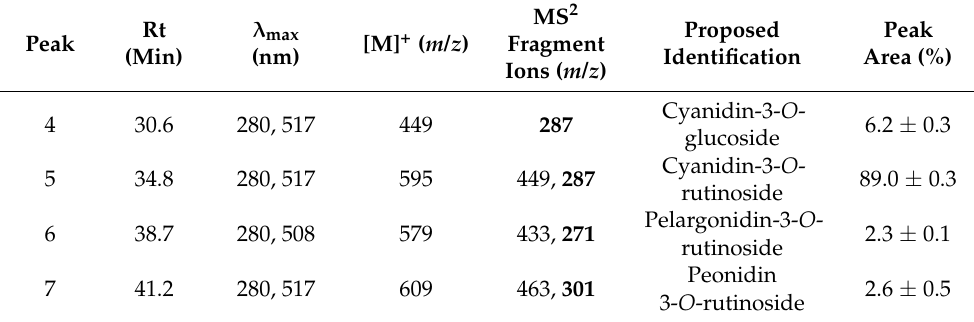
Figure 1. Chromatograms of açaí hydroethanolic extract (AHE) obtained at 280 nm ( A ), 340 ( B ) and 520 ( C ). Identified signals are presented in Tables 1 and 2. Table 1. Retention time, maximum absorbance wavelengths and main fragments of anthocyanins tentatively assigned in AHE by HPLC-DAD-ESI-MS n , in positive ionization mode. The relative abundance of anthocyanins in AHE is presented as % of total peak area ± standard deviation (SD).